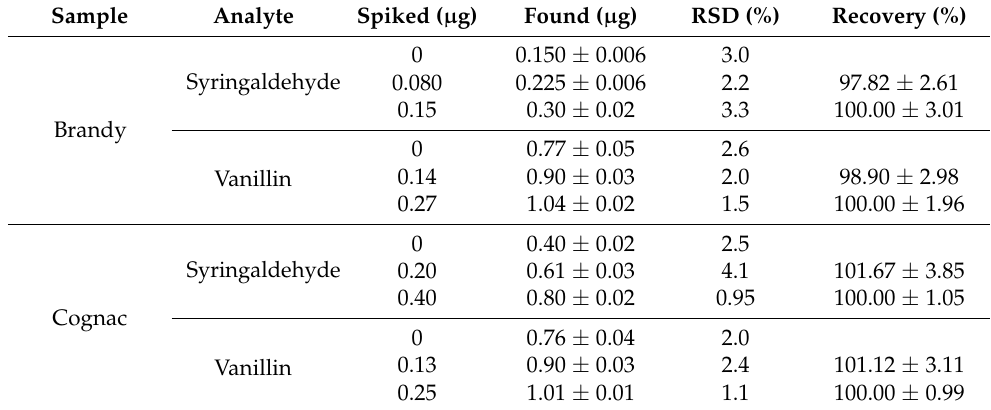
Table 7. Recovery of syringaldehyde and vanillin in brandy and cognac samples ( n = 5; p =